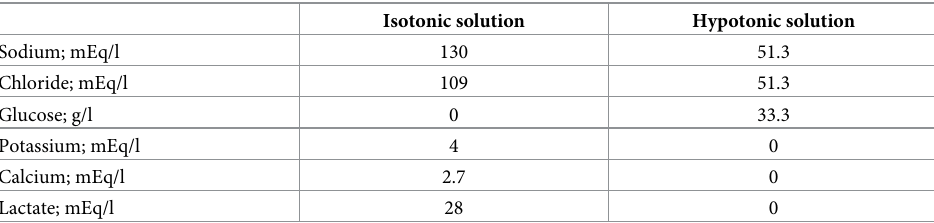
Table 1. Composition of the study